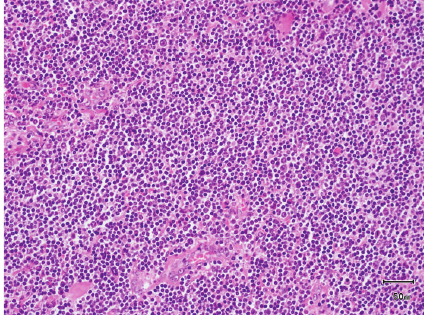
Figure 3: Histology demonstrating lymphoid infiltrate with a dif- fuse and vaguely nodular growth pattern composed of small, cleaved lymphocytes with centrocyte-like morphology and inconspicuous